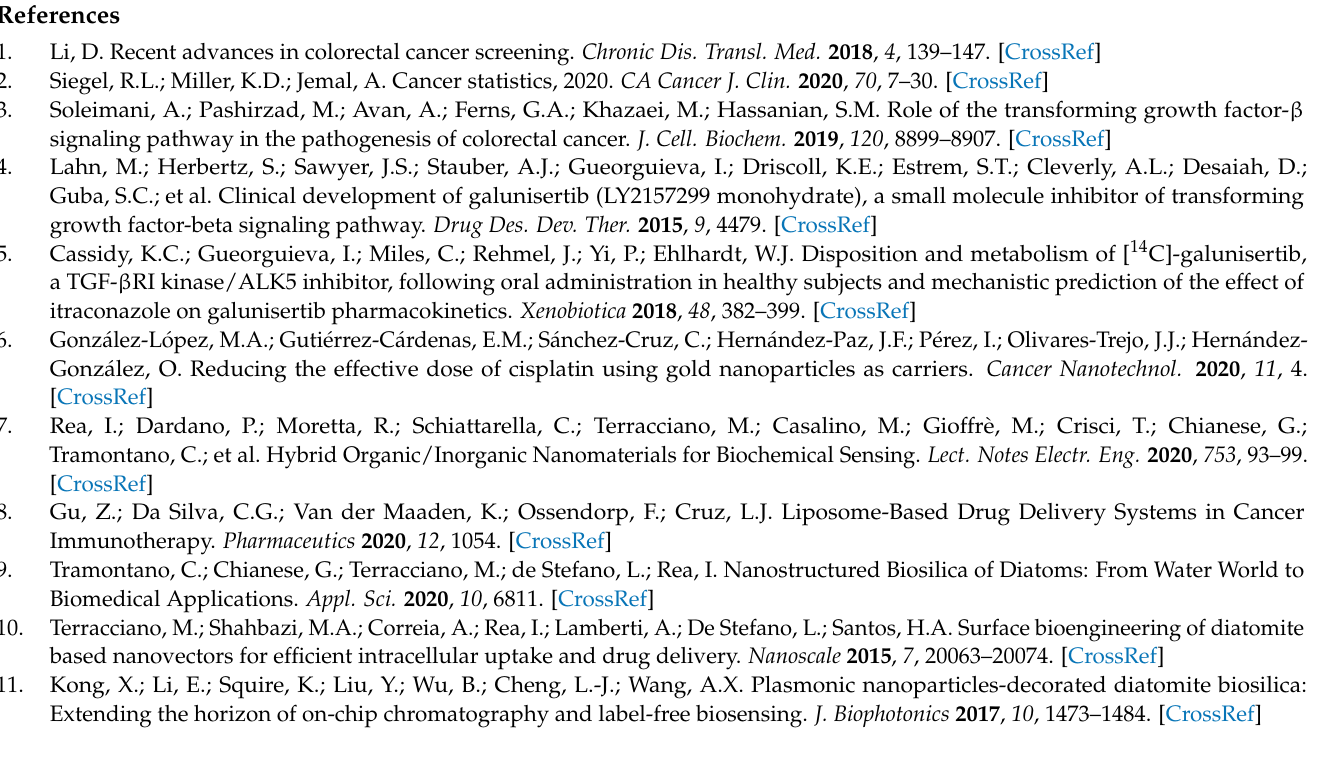
Figure S4—Intrinsic absorptions of the single components of the AuDNP-LY@Gel system; Figure S5—pH-responsive behavior of the AuDNP-LY@Gel system in different buffer solutions; Figure S6—Experimental absorption spectra of AuDNPs with increasing gelatin concentrations; Figure S7—Validation of the core-shell model compared to standard Au@SiO 2 NPs reported in the